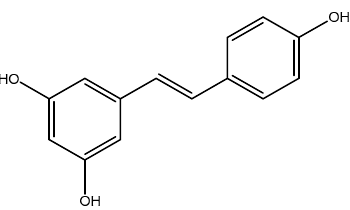
Figure 13. Chemical structure of resveratrol.